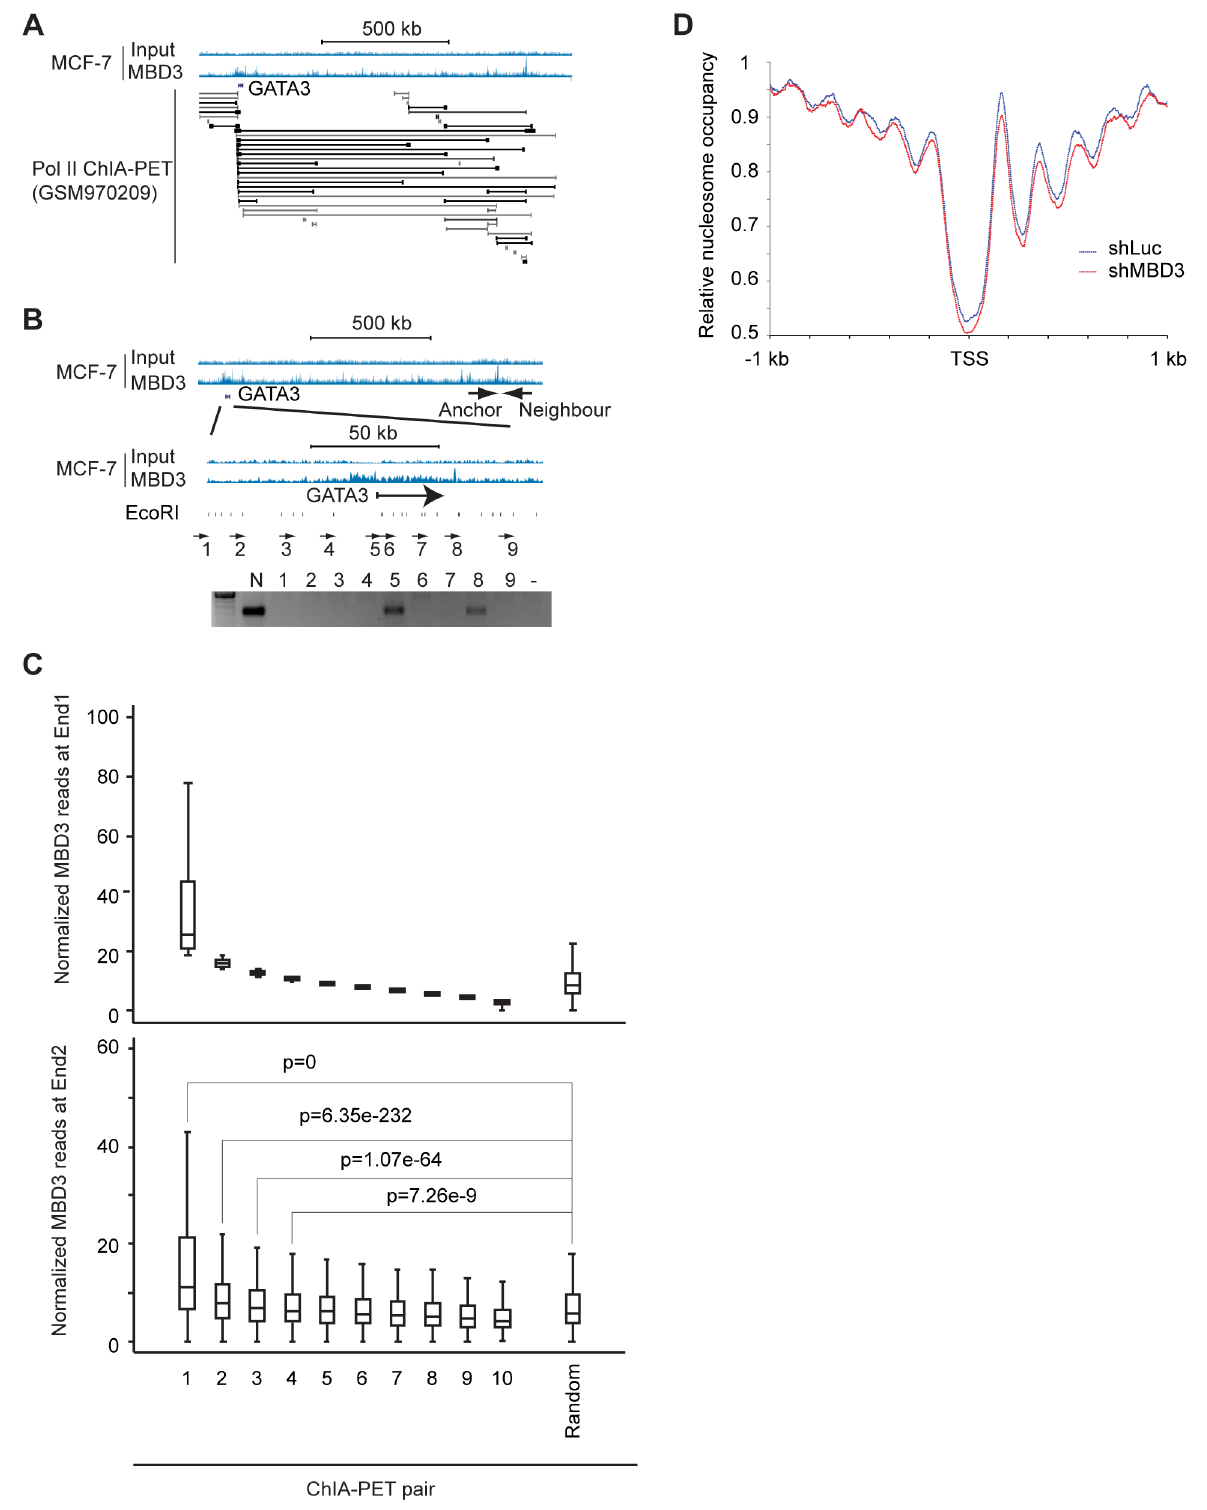
Figure 6. Non-TSS MBD3 peaks overlapping H3K27ac are in proximity to promoters. A. The genome browser view displays the genomic region around the human GATA3 locus. MBD3 ChIP-seq data is depicted at the upper portion of the panel along with a scale bar. ChIA-PET read pairs derived from GSM970209 are depicted in the lower portion of the panel. B. The genome browser view displays the same genomic region of the GATA3 locus depicted in panel A. The location of the anchor primer is depicted in the upper panel of tracks. The region indicated is expanded in the lower set of tracks to display primer sets around GATA3. The location of EcoRI sites within the region is indicated below the tracks. The gel displays PCR products using the anchor primer in PCR with the indicated primers tiling across GATA3. C. MBD3 read depth was plotted for all genes where Pol II ChIA-PET pairs exist with one end anchored at TSS (see Methods). ChIA-PET pairs were rank ordered by MBD3 density at the TSS end (end 1) and